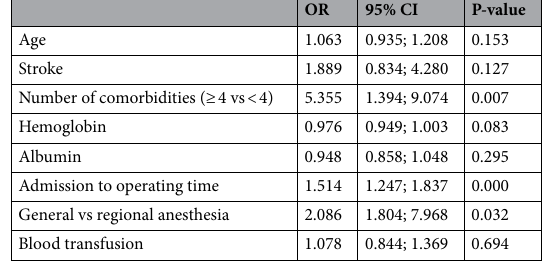
Table 3. Multivariable analysis for factors associated with postoperative delirium in nonagenarians with hip fracture.